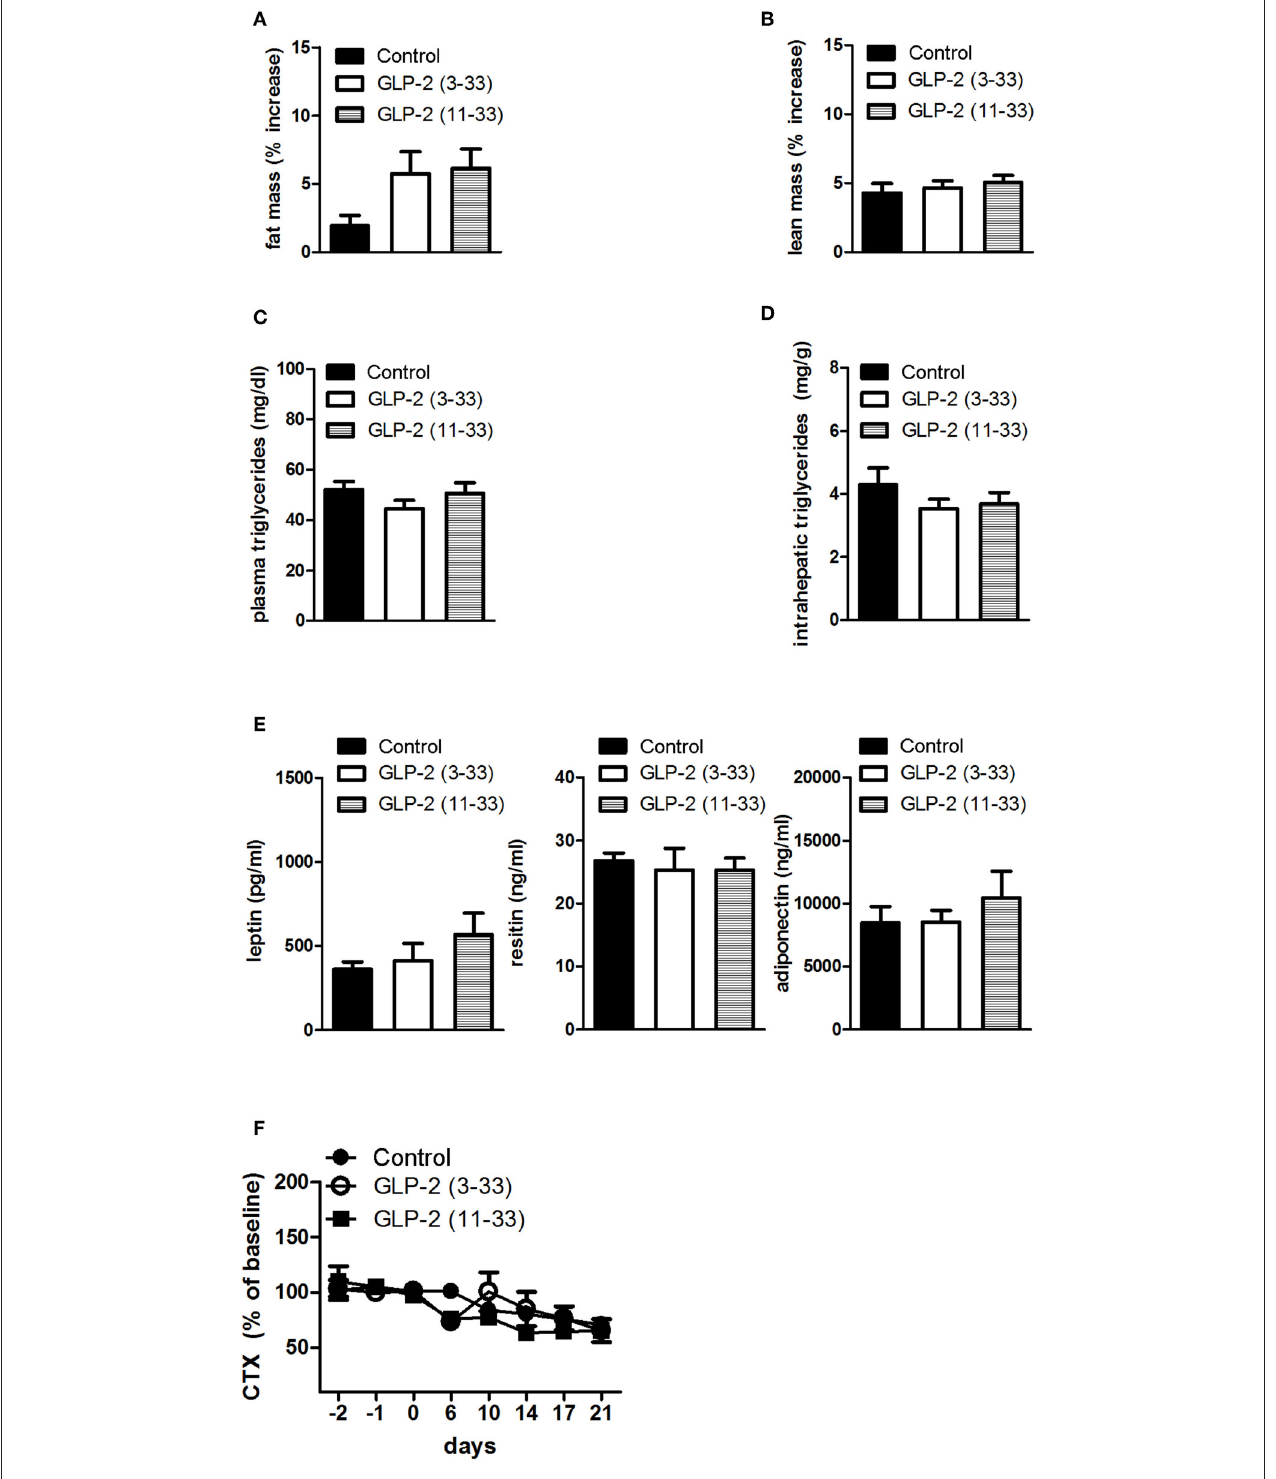
FIGURE 4 | Effects of the subchronic treatment with GLP-2(11-33) (25 nmol/kg b.w.), GLP-2(3-33) (25 nmol/kg b.w.) or vehicle treated on total body composition, triglycerides, adipokines, and CTX: Changes in total fat (A) and lean (B) mass, measured by NMR, plasma triglycerides (C) , intrahepatic triglycerides (D) , plasma adipokine levels (E) , serum CTX levels (F) expressed as percent of the mean of the baseline values (days − 2, − 1, 0) of the individual animal. Data are mean values ± S.E.M. ( n = 6 rats/group).